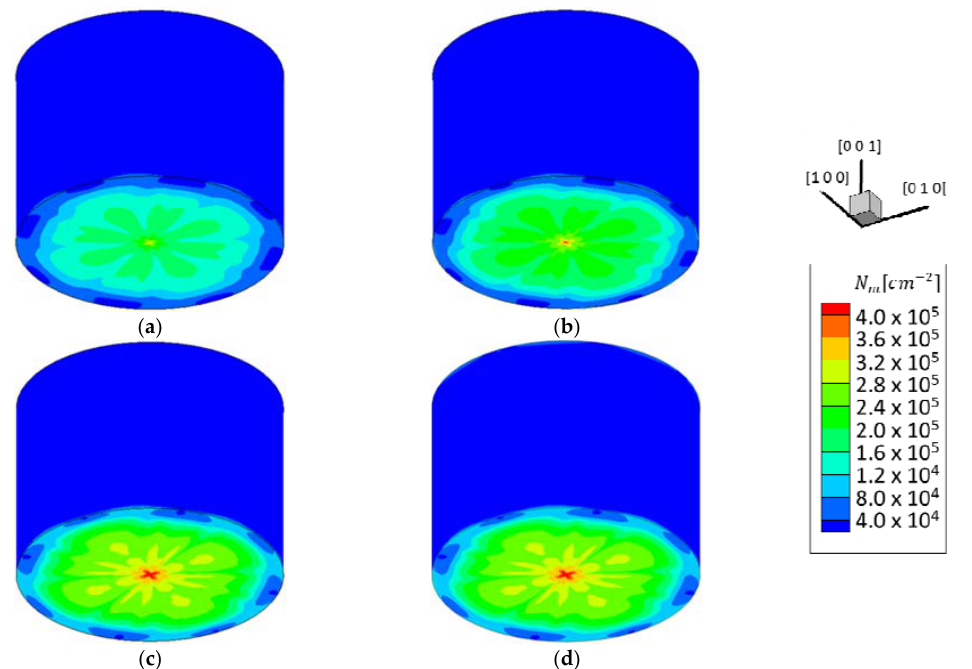
Figure 5. The calculated distributions of dislocation in a crystal 282 ( a ); 314 ( b ); 466 ( c ); and 720 ( d ) min after the initiation of the solidification, respectively.